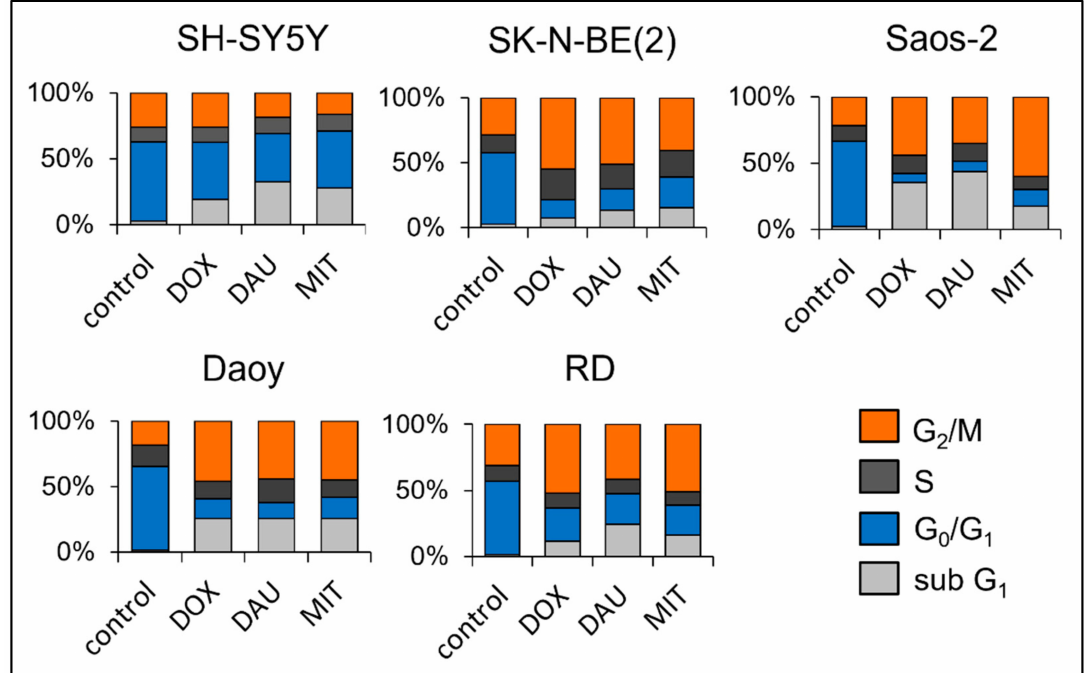
Figure 5. Analysis of the cell cycle using propidium iodide staining. Cell cycle analysis of selected cell lines (SH-SY5Y, SK-N-BE(2), Saos-2, Daoy, and RD cells) was performed by quantification of the DNA content with propidium iodide staining and subsequent flow cytometry detection. Changes in the cell cycle were obtained after 72 h of treatment with IC 50 doses of doxorubicin (DOX), daunorubicin (DAU), or mitoxantrone (MIT). The graphs show the mean proportion of cells (%) in the cell cycle phases: sub G 1 , G 0 /G 1 , S, and G 2 /M. The detailed table showing the means ± SD